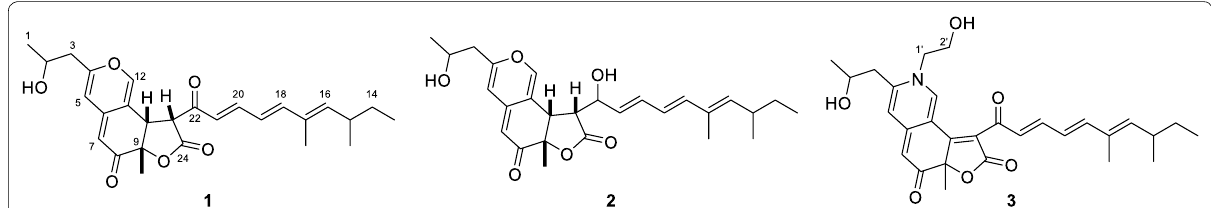
Fig. 3 Numbered structures of sassafrin E ( 1 ), sassafrin F ( 2 ), and sassafrinamine A ( 3 ). Relative configuration is shown for C9 , C10 and